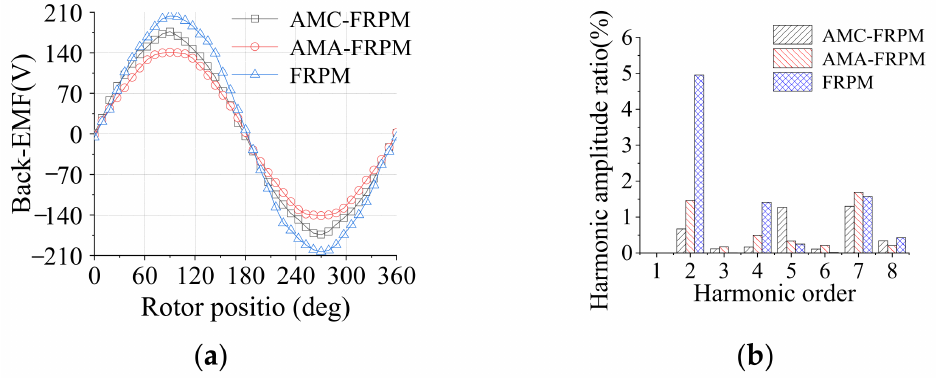
Figure 16. Back-EMFs of the three machines. ( a ) Back-EMF waveforms. ( b ) Harmonic distributions.